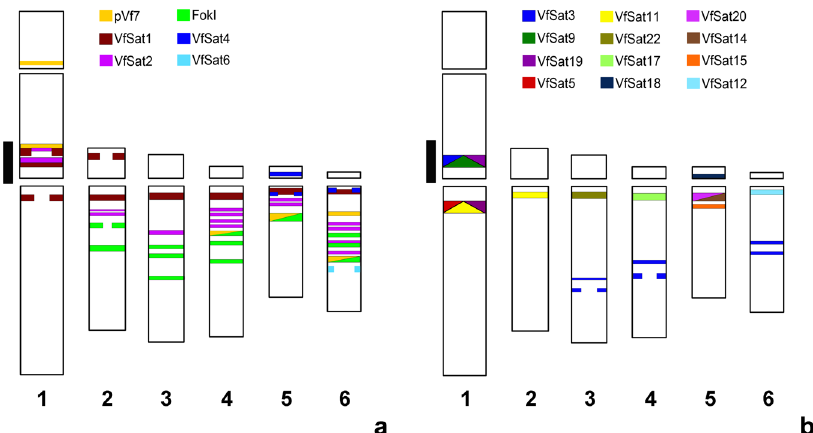
Figure 2. Schematic representation of genomic distributions of all non-centromeric satellites mapped by FISH. Satellites with short monomers are shown in ( a ), while those with long monomers exceeding 600 bp are in panel ( b ). The black line along chromosome 1 marks the region of accumulation of multiple satellite